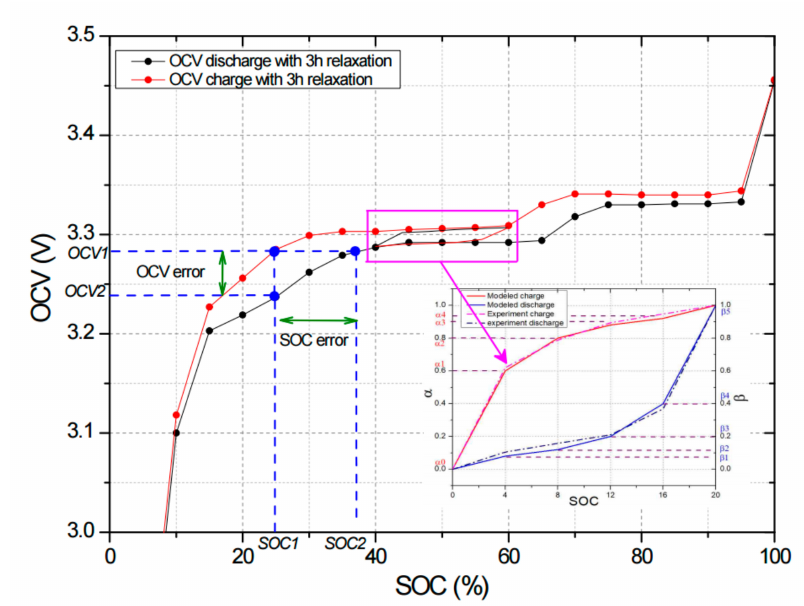
Figure 3. SOC-OCV curve (major loop hysteresis) of LiFePO 4